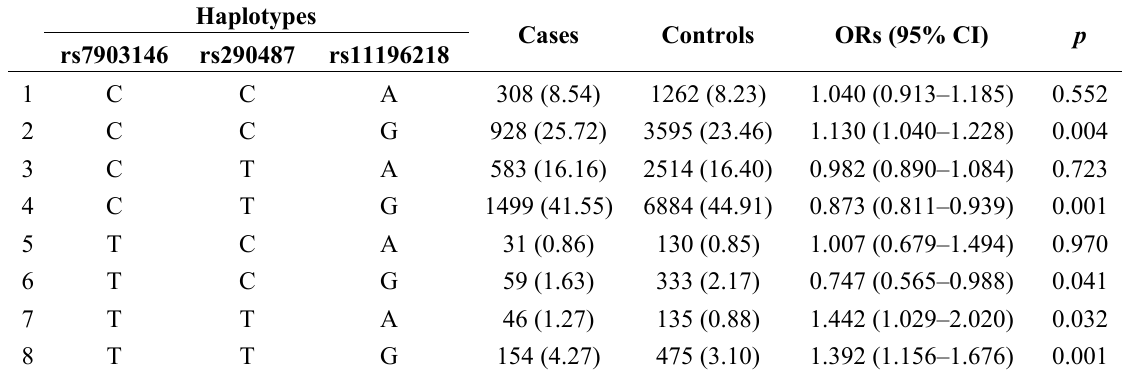
Table 7. Associations of haplotypes of SNPs in TCF7L2 gene and T2DM.